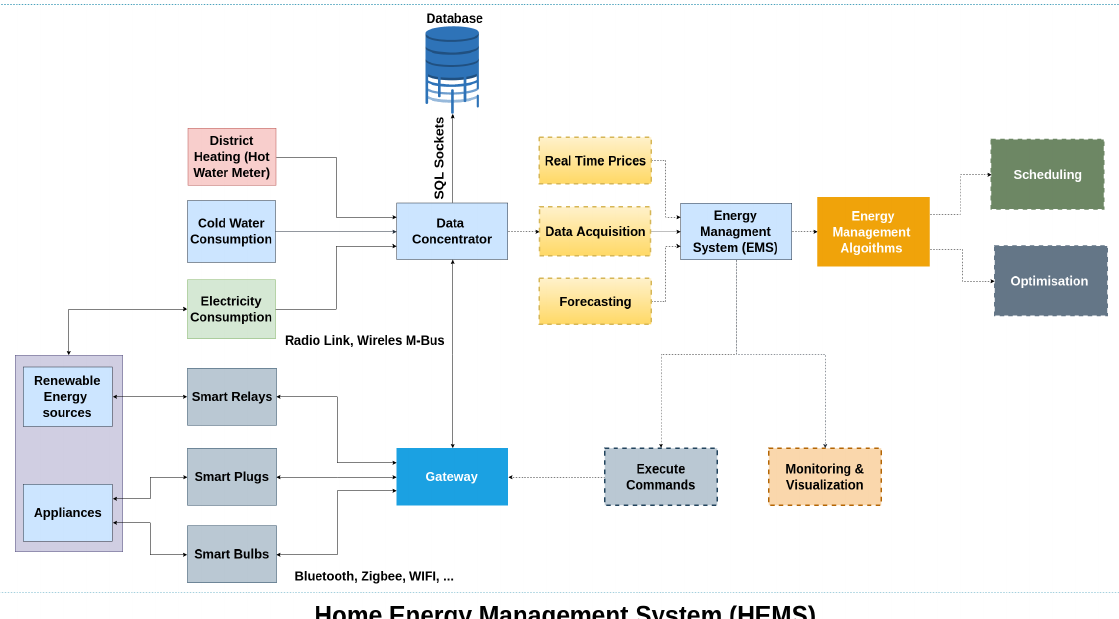
Figure 17. Architecture of the